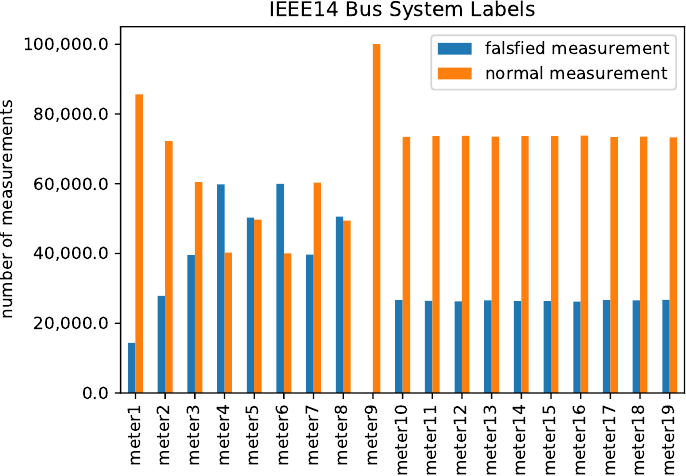
Figure 3. Unbalanced labels for normal and falsified meters under L 2 -norm of